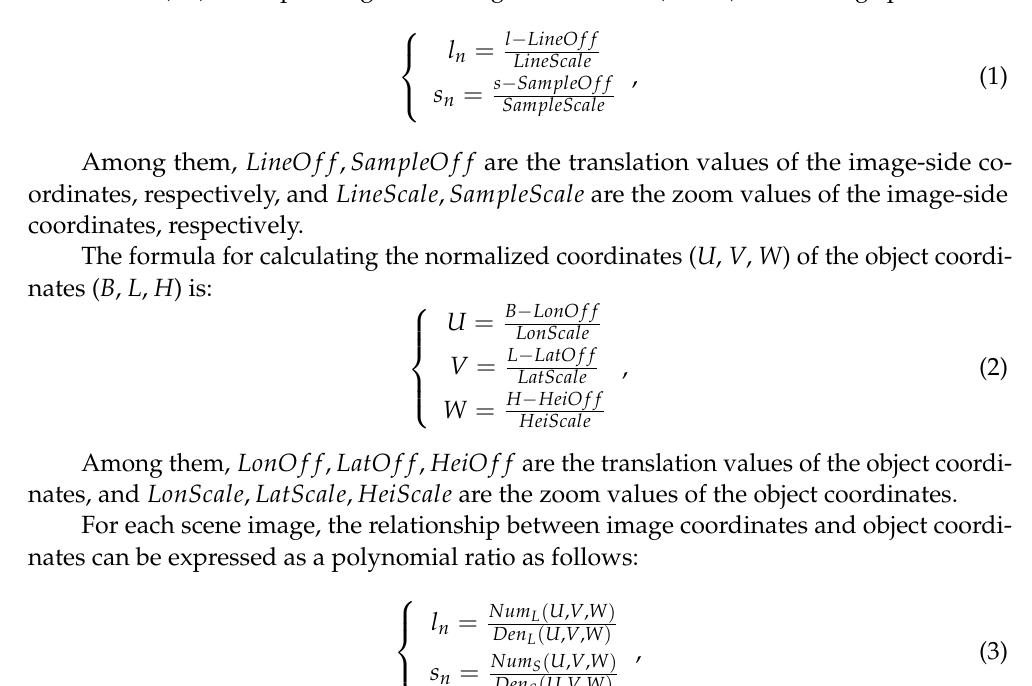
Figure 1. Calculate the overlap range. See Equation (1) for definitions of parameters. In order to ensure the stability of the calculation, RFM regularizes the image coordi- nates ( l , s ), latitude and longitude coordinates ( B , L ), and the height of ellipsoid H to make the coordinate range between [ − 1, 1]. The formula for calculating the normalized image coordinates ( l , s ) corresponding to the image coordinates ( l n , s n ) of the image point is: